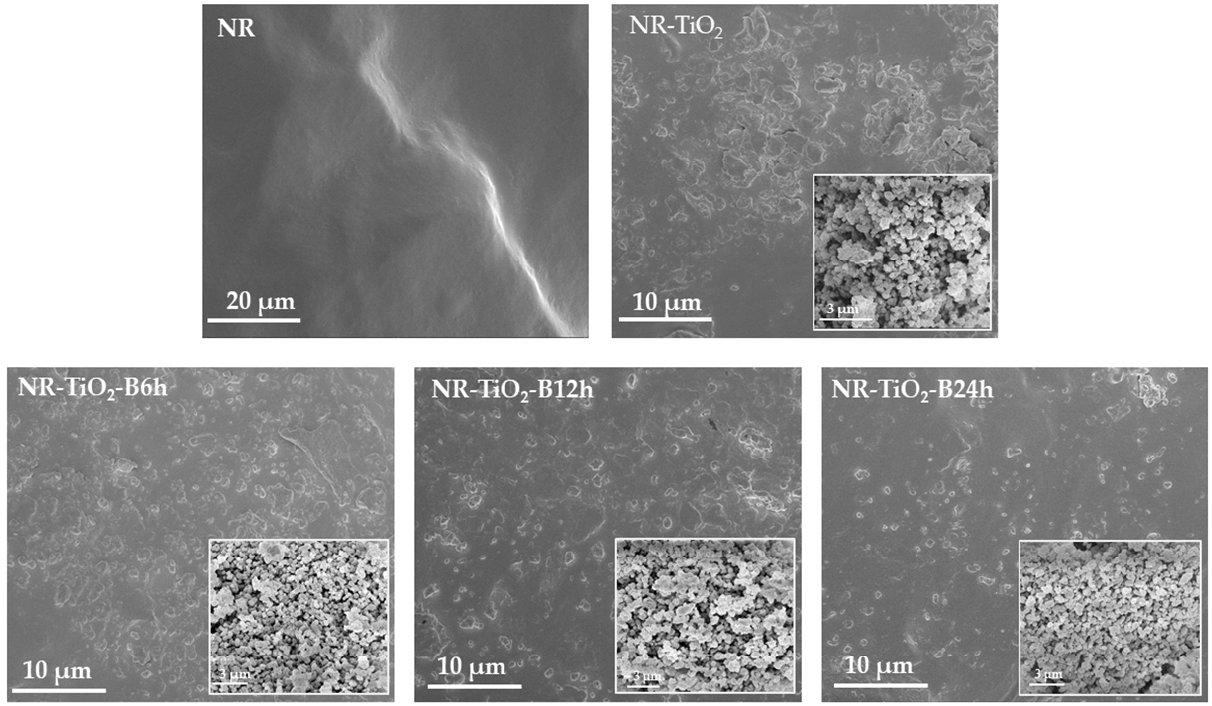
Figure 5. SEM images of the pristine NR film, NR-TiO 2 , NR-TiO 2 -B6h, NR-TiO 2 -B12h and NR-TiO 2 -B24h composite films at 0.5%wt with the insets of their TiO 2 particles fillers.